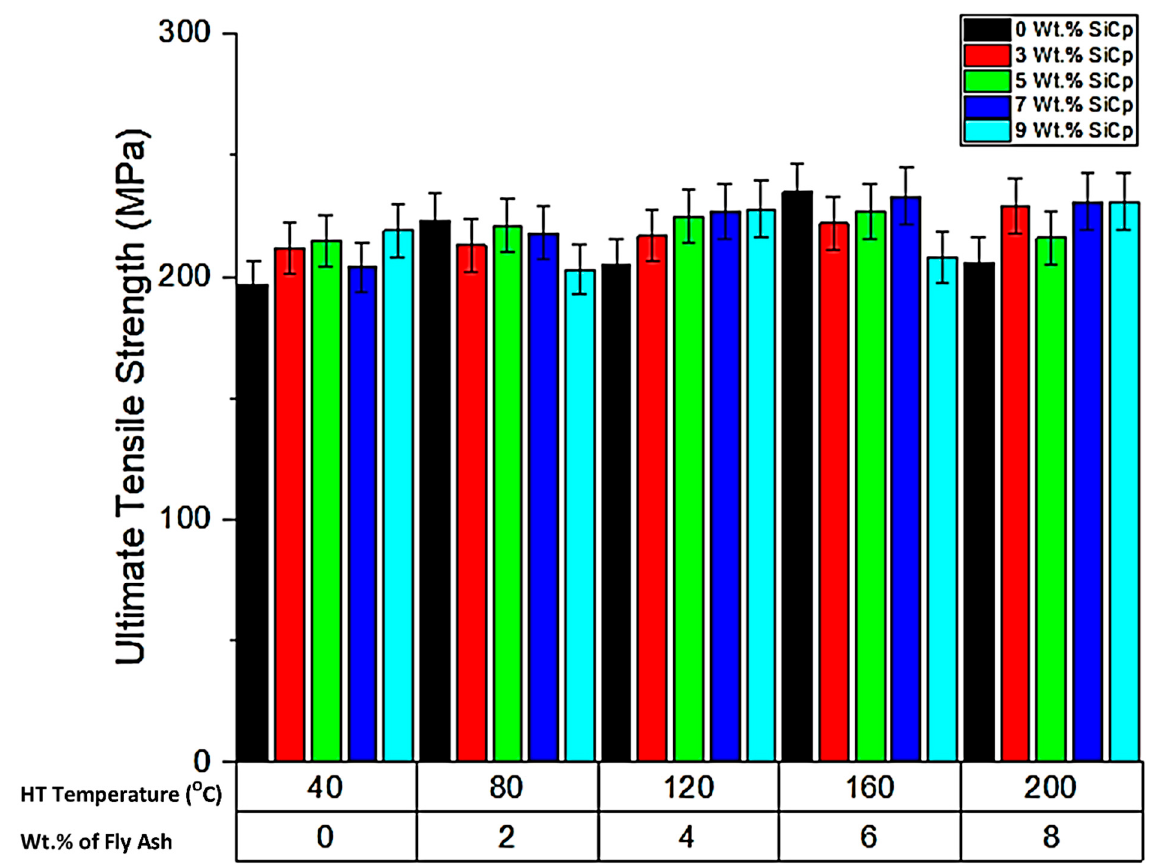
Figure 9. Variation of UTS for different experimental conditions.